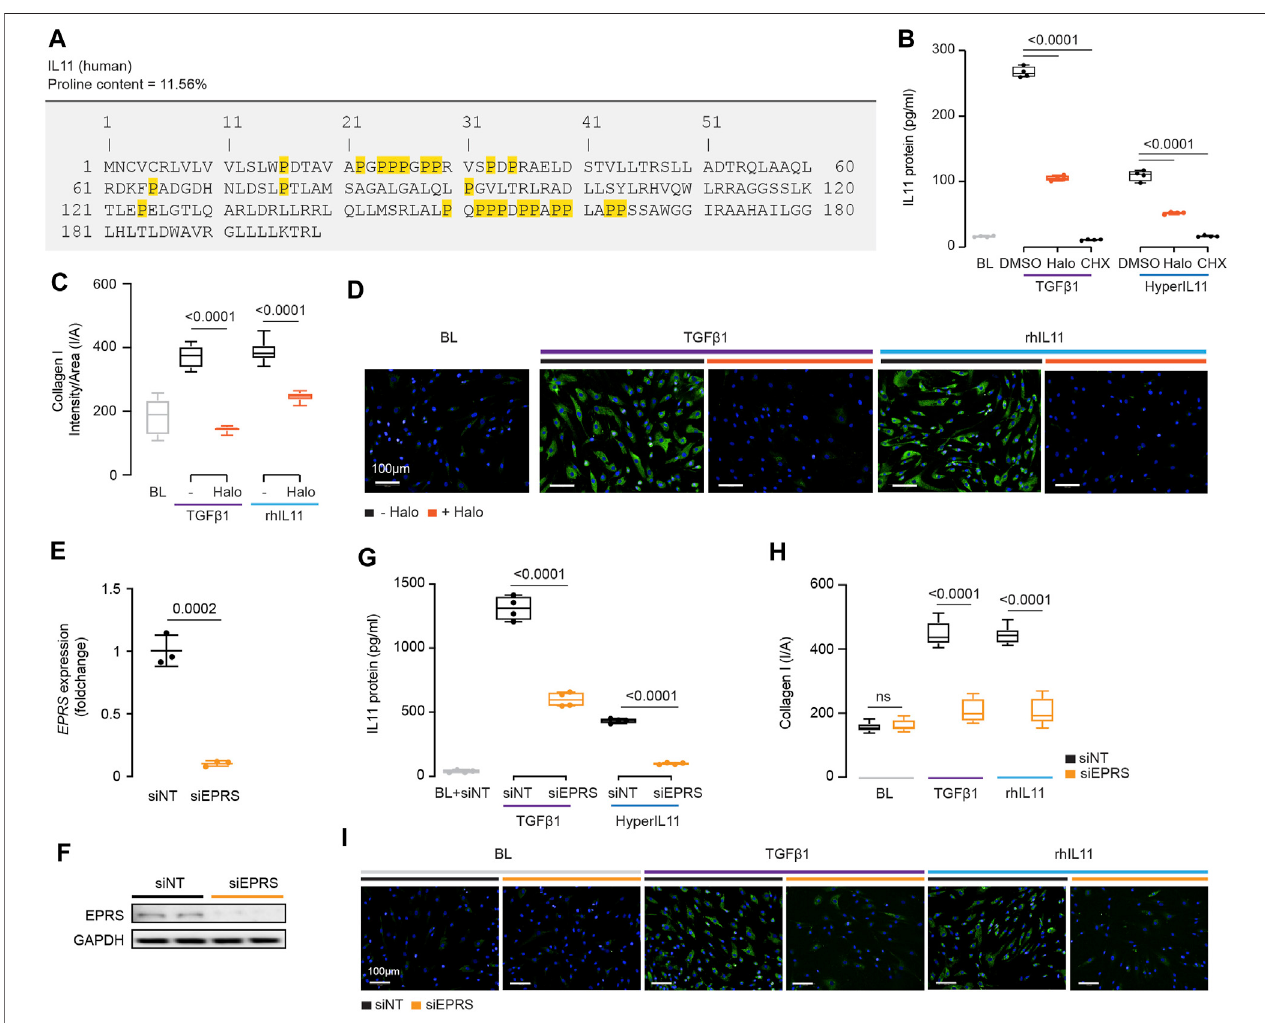
FIGURE4| IL11promotesthetranslation ofproline-richpro- fi broticgenes,includingitself,throughEPRSactivity. (A) AminoacidsequenceofhumanIL11,proline residueshighlightedinyellow. (B) IL11levelsinthesupernatantfollowingTGF β 1orHyperIL11 stimulation inthepresenceofHalofuginone(Halo)orCycloheximide (CHX) ( n (cid:2) 3). (C,D) (C) Quanti fi cation ( n (cid:2) 14) and (D) immuno fl uorescence images (scale bars, 100 μ m; n (cid:2) 3)) of Halofuginone-treated TGF β 1/IL11-stimulated HCFs for Collagen I staining. (E,F) (E) EPRS mRNA ( n (cid:2) 3) and (F) EPRS protein ( n (cid:2) 2) expression levels after knockdown using siEPRS. (G – I) (G) IL11 levels in the supernatant( n (cid:2) 4), (H) quanti fi cation(n (cid:2) 14),and (I) immuno fl uorescenceimages(scalebars,100 μ m; n (cid:2) 3)ofCollagenIinstimulatedHCFssubjectedtosiEPRS. (B – I) primary HCFs; IL11/TGF β 1/HyperIL11 (10 ng/ml), Cycloheximide (CHX, 100 μ g/ml), Halofuginione (100 nM), non-targeting siRNA (siNT)/EPRS siRNA (siEPRS) (12.5 nM); 24 h. (B,C, G,H) Data are shown as box-and-whisker with median (middle line) , 25th – 75th percentiles (box) and min-max percentiles (whiskers); one-way ANOVA with Tukey ’ s correction; (E) Data are shown as mean ± SD, 2-tailed t -test. Signaling relationships between nintedanib, pirfenidone and